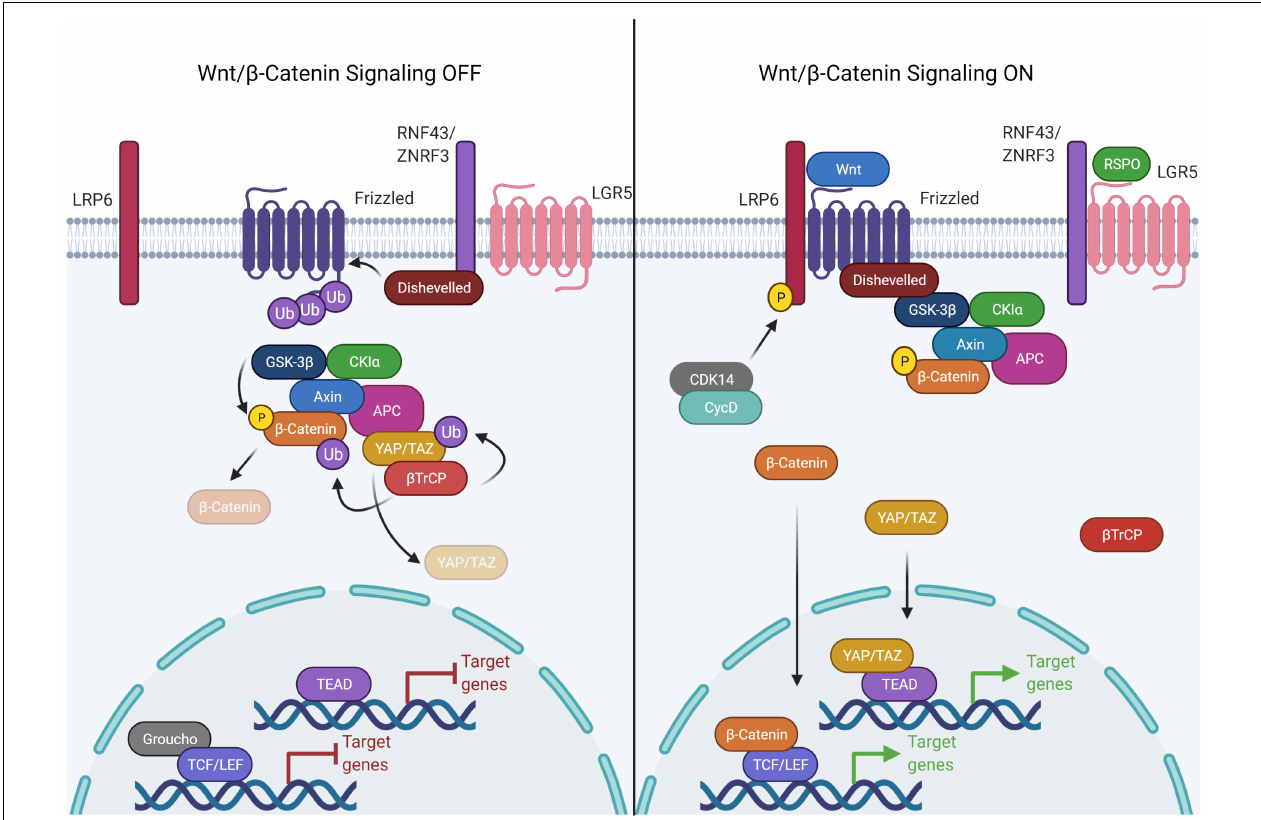
FIGURE 1 | Components of the canonical Wnt signaling pathway. The canonical Wnt pathway is primarily dependent on the transcriptional activity of β -catenin. In the Wnt OFF state, the Wnt destruction complex is actively engaged in the phosphorylation and subsequent ubiquitination mediated degradation of β -catenin. This is achieved by sequestering β -catenin to the Wnt destruction complex, consisting of APC, AXIN (scaffold proteins), GSK3 β , and CK1 α (kinases). Upon phosphorylation by the kinases, β -catenin is ubiquitinated by β TrCP which is recruited to the destruction complex by YAP/TAZ. The DNA binding partner of β -catenin, TCF/LEF, is bound to the DNA in a repressive complex with Groucho/TLE. Wnt signaling is activated upon binding of Wnt ligand causing complex formation between LRP6 and frizzled which allows Disheveled to bind to LRP. This activated form of Disheveled is able to bind and recruit the Wnt destruction complex thereby disrupting the binding of β TrCP. The receptor bound Wnt destruction complex is ubiquitination incompetent, hence β -catenin can’t be targeted for proteasomal degradation, therefore leading to saturation of the destruction complex with phospho- β -catenin. The new pool of β -catenin is free to translocate into the nucleus and activate the transcription of Wnt responsive genes by binding the TCF/LEF family of transcription factors. In the same process, YAP/TAZ is unable to recruit β -TrCP to the destruction complex and escape degradation. YAP/TAZ translocates into the nucleus as well and binds to the TEAD family of transcription